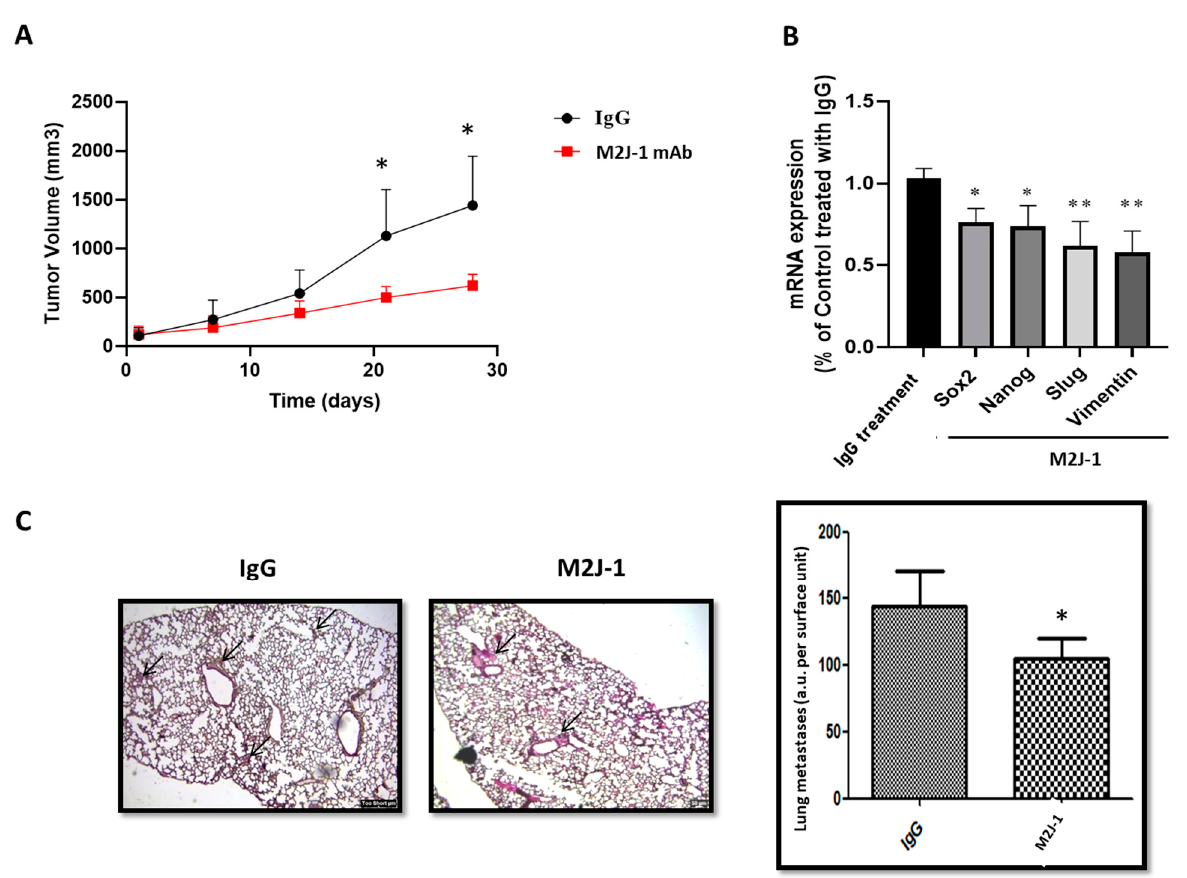
Figure 7. Effect of M2J ‐ 1 mAb in two in vivo experimental models. ( A ): Effect of anti ‐ sCD146 antibody M2J ‐ 1 500 μ g/kg compared to IgG, on tumor volume in an in vivo model of CD146 ‐ high MDA ‐ MB ‐ 231 cells subcutaneously injected in nude mice. Four mice were used in each group. ( B ): Expression of CSC (Sox 2 and Nanog) and EMT (Slug and Vimentin) markers at the mRNA level (qPCR) in tumors from IgG and M2J ‐ 1 treated mice. ( C ): Histological analysis of lung metastases (arrows) in an experimental model of intracardiac injection of CD146 ‐ high MDA ‐ MB ‐ 231 cells and treatment with M2J ‐ 1 mAb 500 μ g/kg as compared to IgG. Six mice were used in each group. Representative experiments and the average of four to five sections for each animal are given. *, **: p < 0.05, p < 0.01, M2J ‐ 1 vs. IgG.